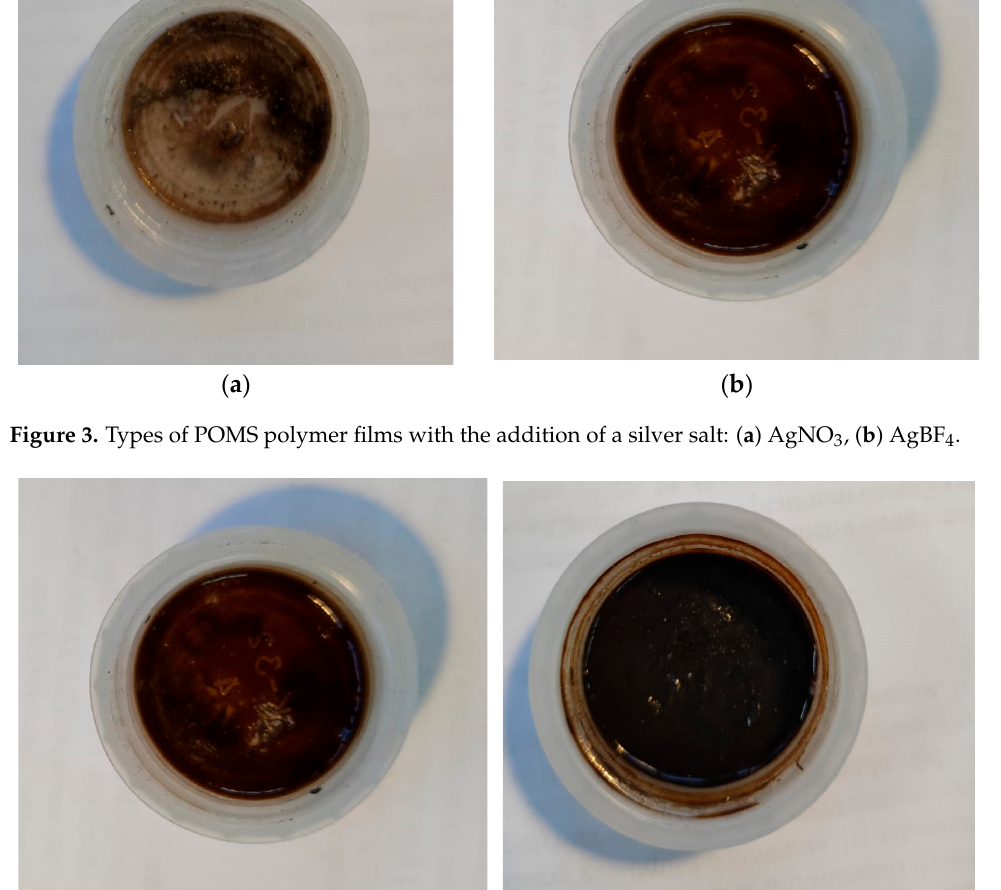
Figure 3. Types of POMS polymer films with the addition of a silver salt: ( a ) AgNO 3 , ( b ) AgBF 4 .